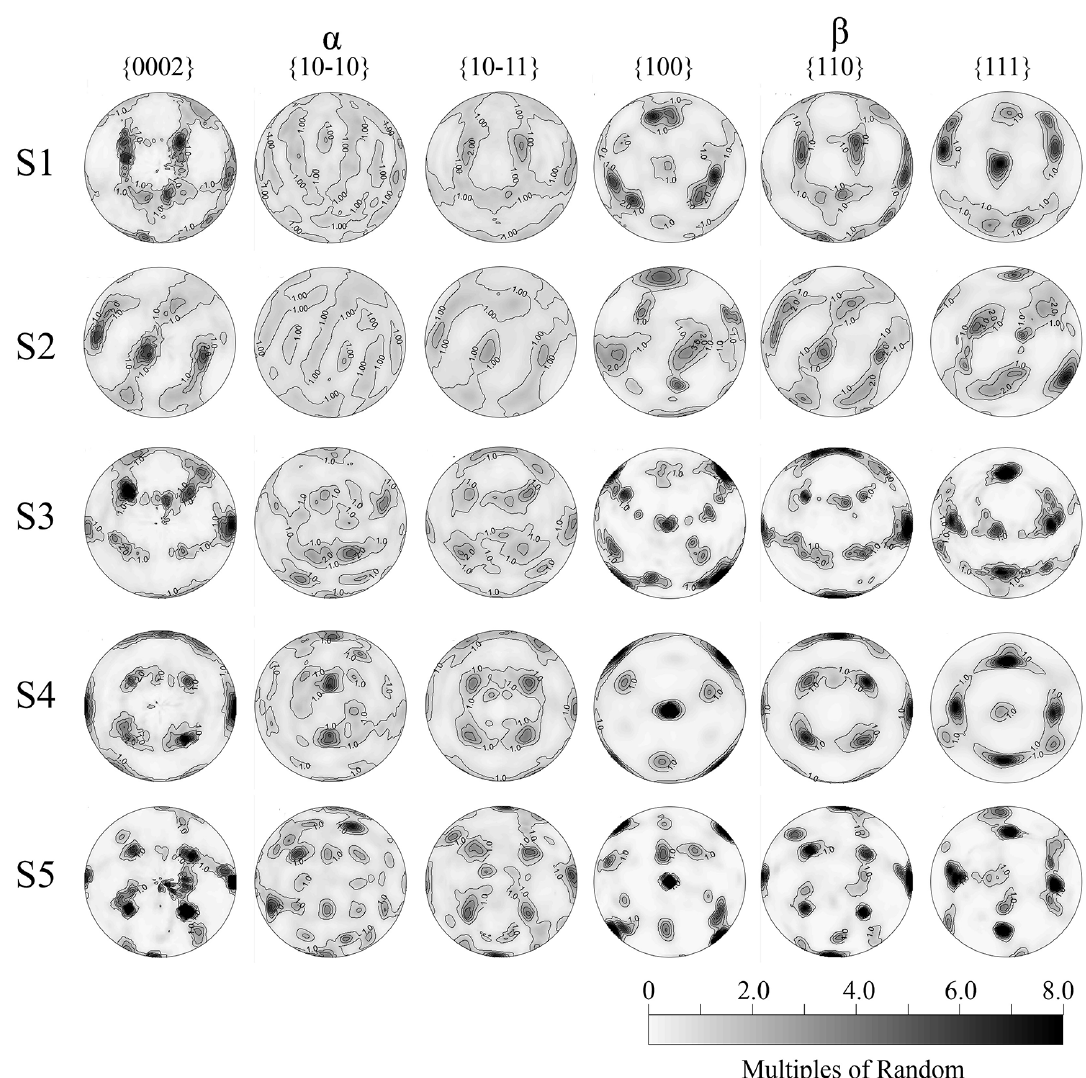
Figure 3. Plot of pole figures from different samples. Equal area projection, upper hemisphere, and pole densities in multiples of random distribution. The north pole of each pole figure is the LD of each sample, and the right pole is the